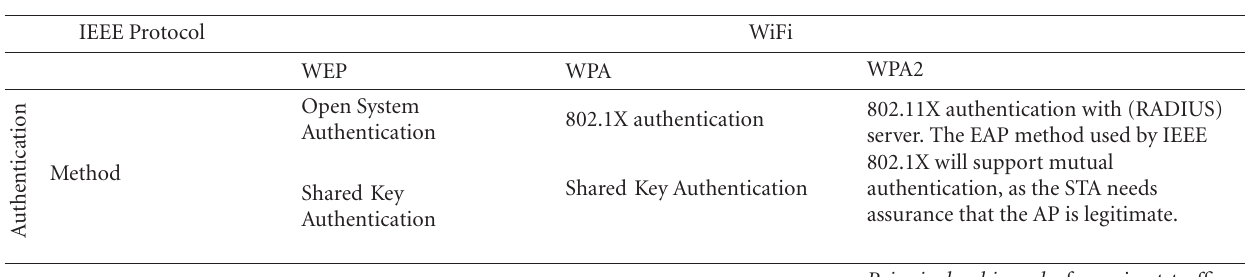
Table 1: WiFi and WiMAX security